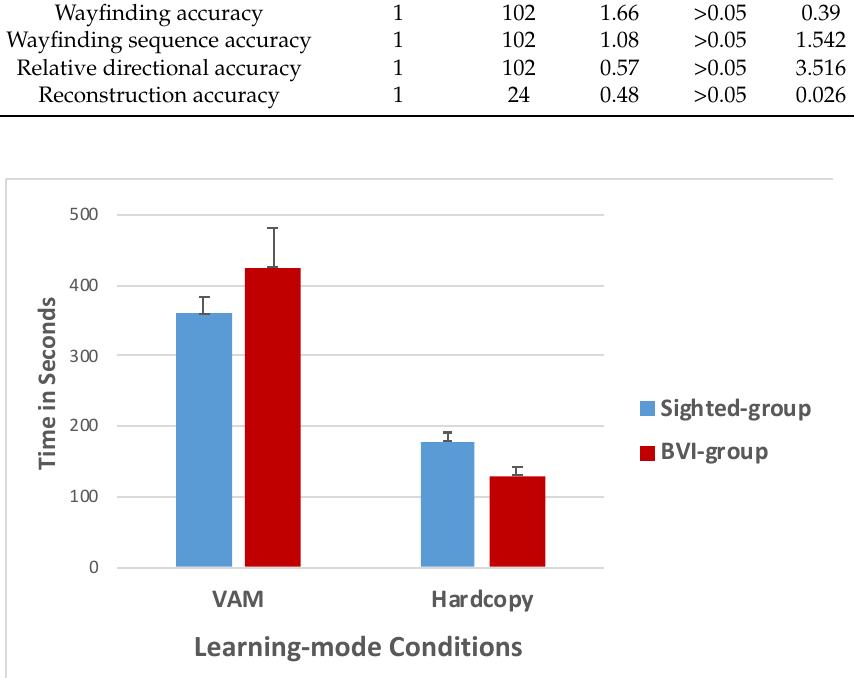
Figure 8. Mean learning time as a function of learning-mode conditions and participant group (right).